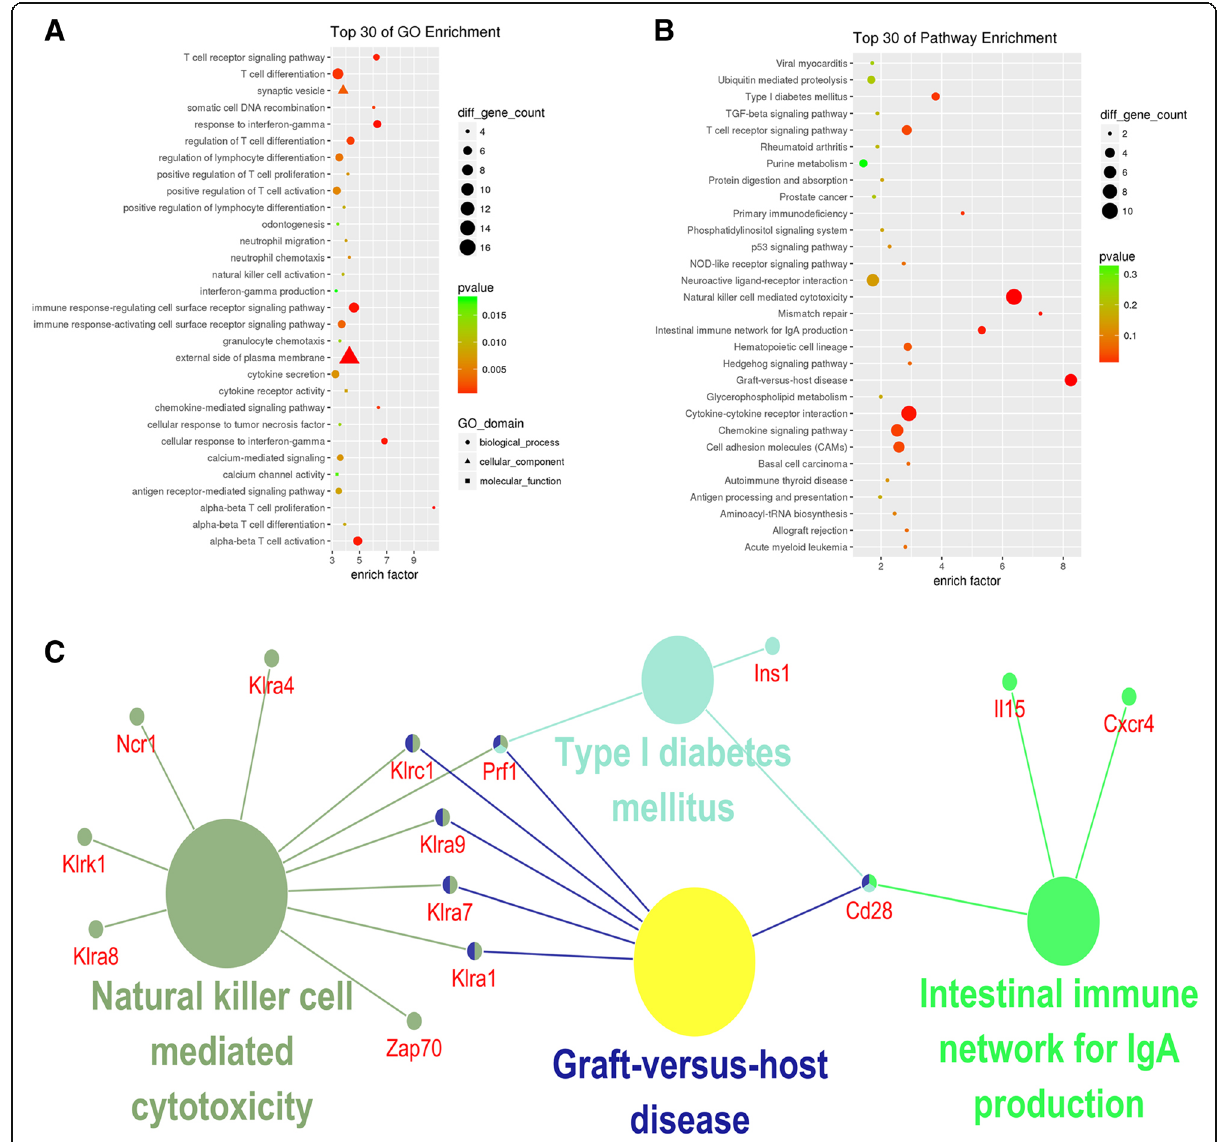
Fig. 3 Functional enrichment of overlapping DEGs. a Top 30 enriched GO terms, y-axis represents GO terms, and x-axis represents enrichment factor. Size and color of the bubble represents amount of DEGs enriched in GO terms and enrichment significance, respectively. b Top 30 enriched KEGG pathways, y-axis label represents pathway names, and x-axis represents enrichment factor. Size and color of the bubble represents amount of DEGs enriched in the pathway and enrichment significance, respectively. c Pathway interaction, each node is a KEGG pathway item; the node size reflects pathway significance, edge between nodes reflected common genes; and different node colors represented different functional